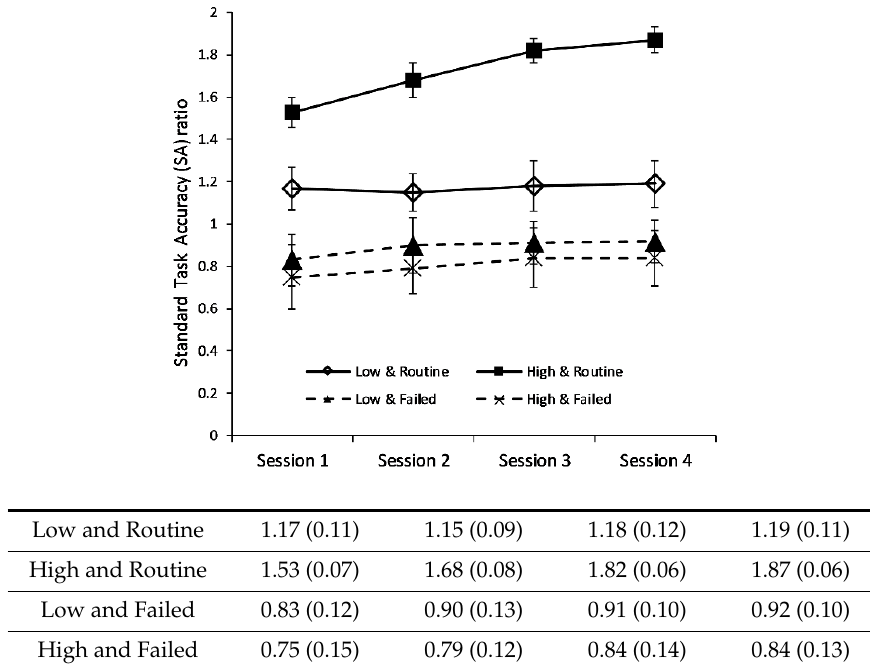
Figure 3. Variations in longitudinal SA ratios in the four sessions.